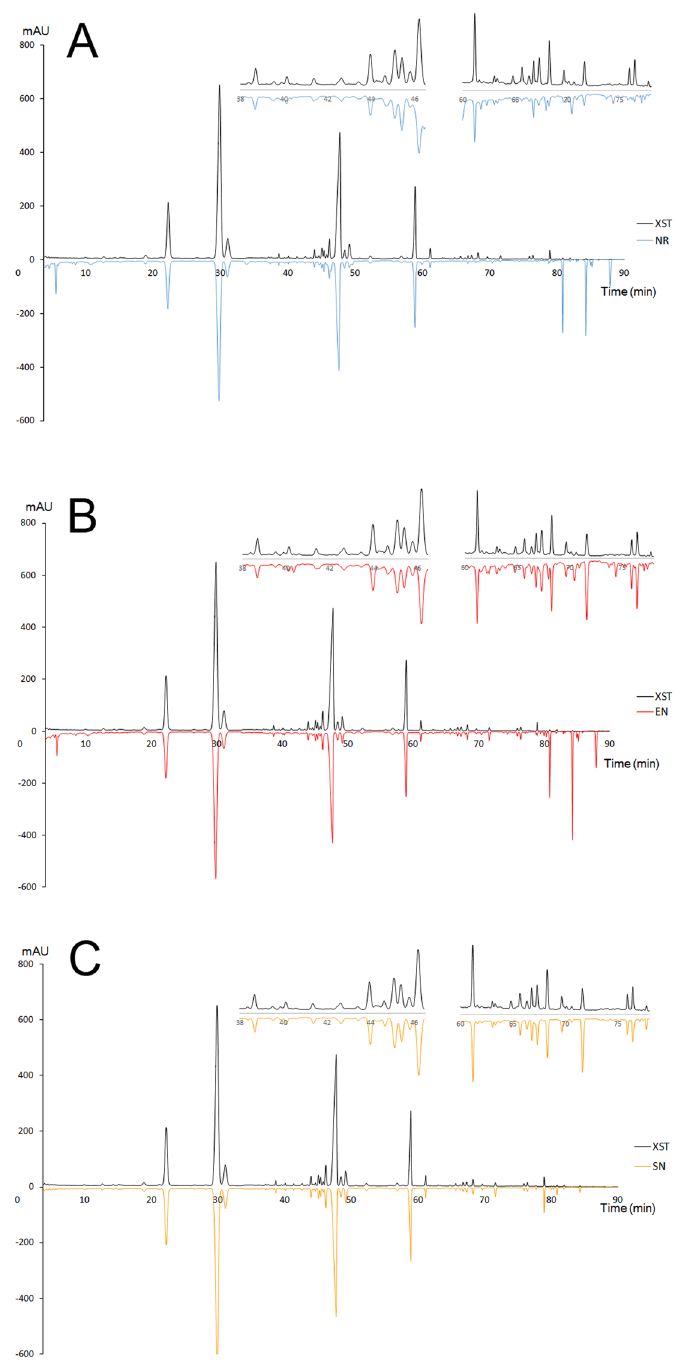
Figure 6. Constituents origins and variations during manufacturing process. ( A ) XST vs. NR, ( B ) XST vs. EN and ( C ) XST vs.